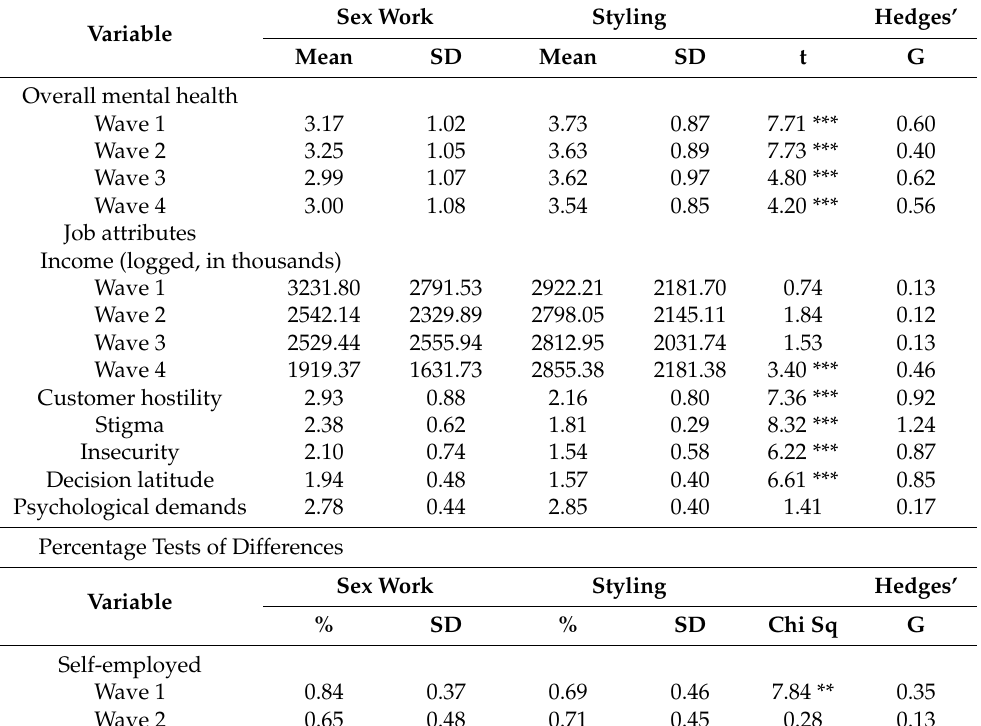
Table 2. Descriptive Statistics, Test of Difference, and Effect Size, Mental Health and Job Attributes +. Sex Variable